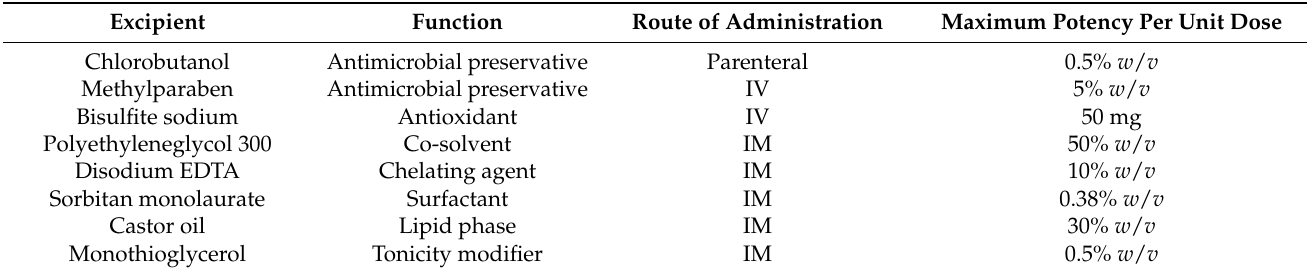
Table 1. List of commonly used excipients in formulation of colloidal